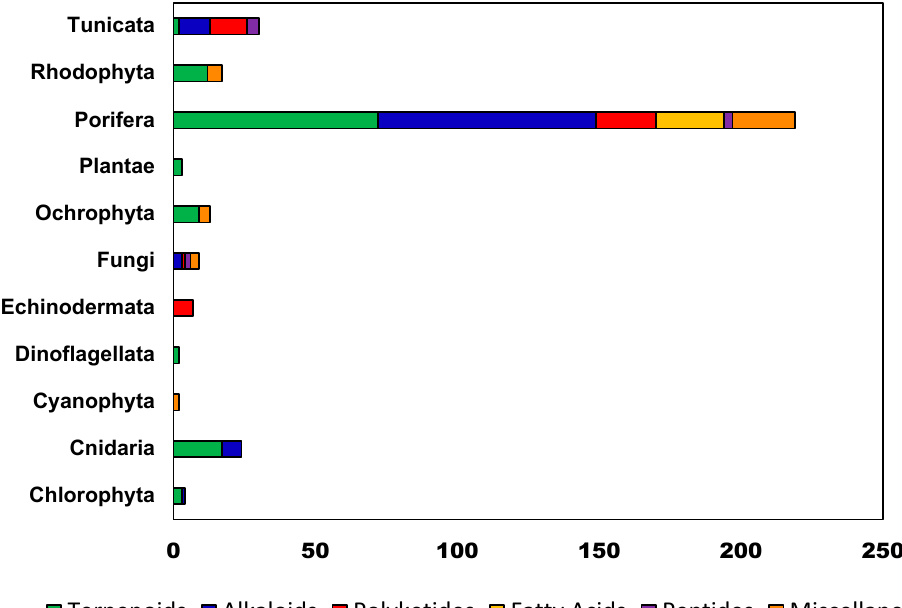
Figure 22. Number of metabolites isolated from Western Australian marine species, classified by taxonomy and putative biogenesis.